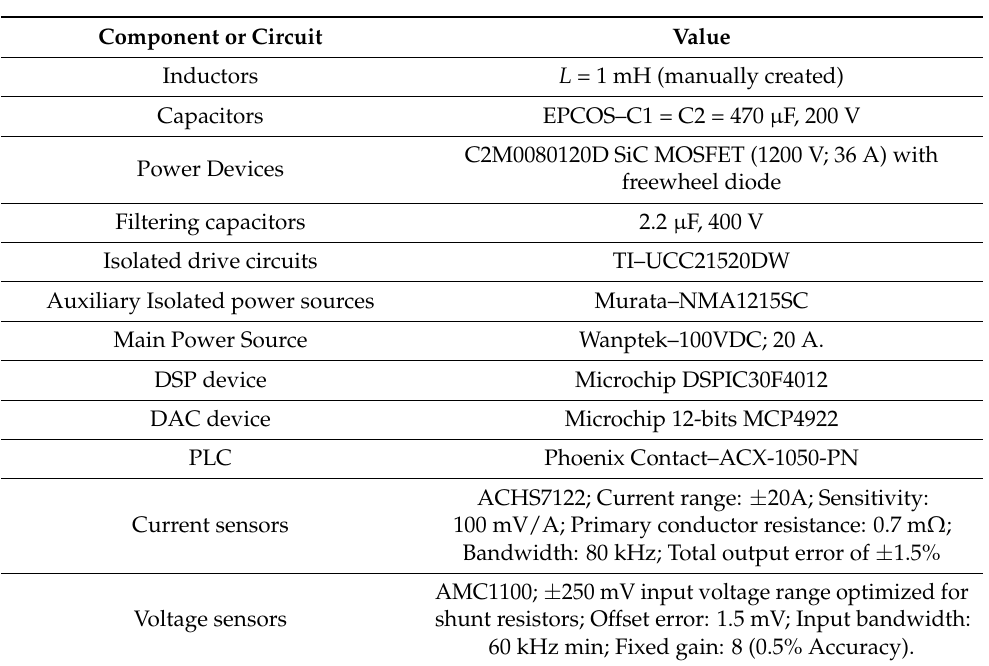
Table 4. Components and circuits used in the laboratory prototype.